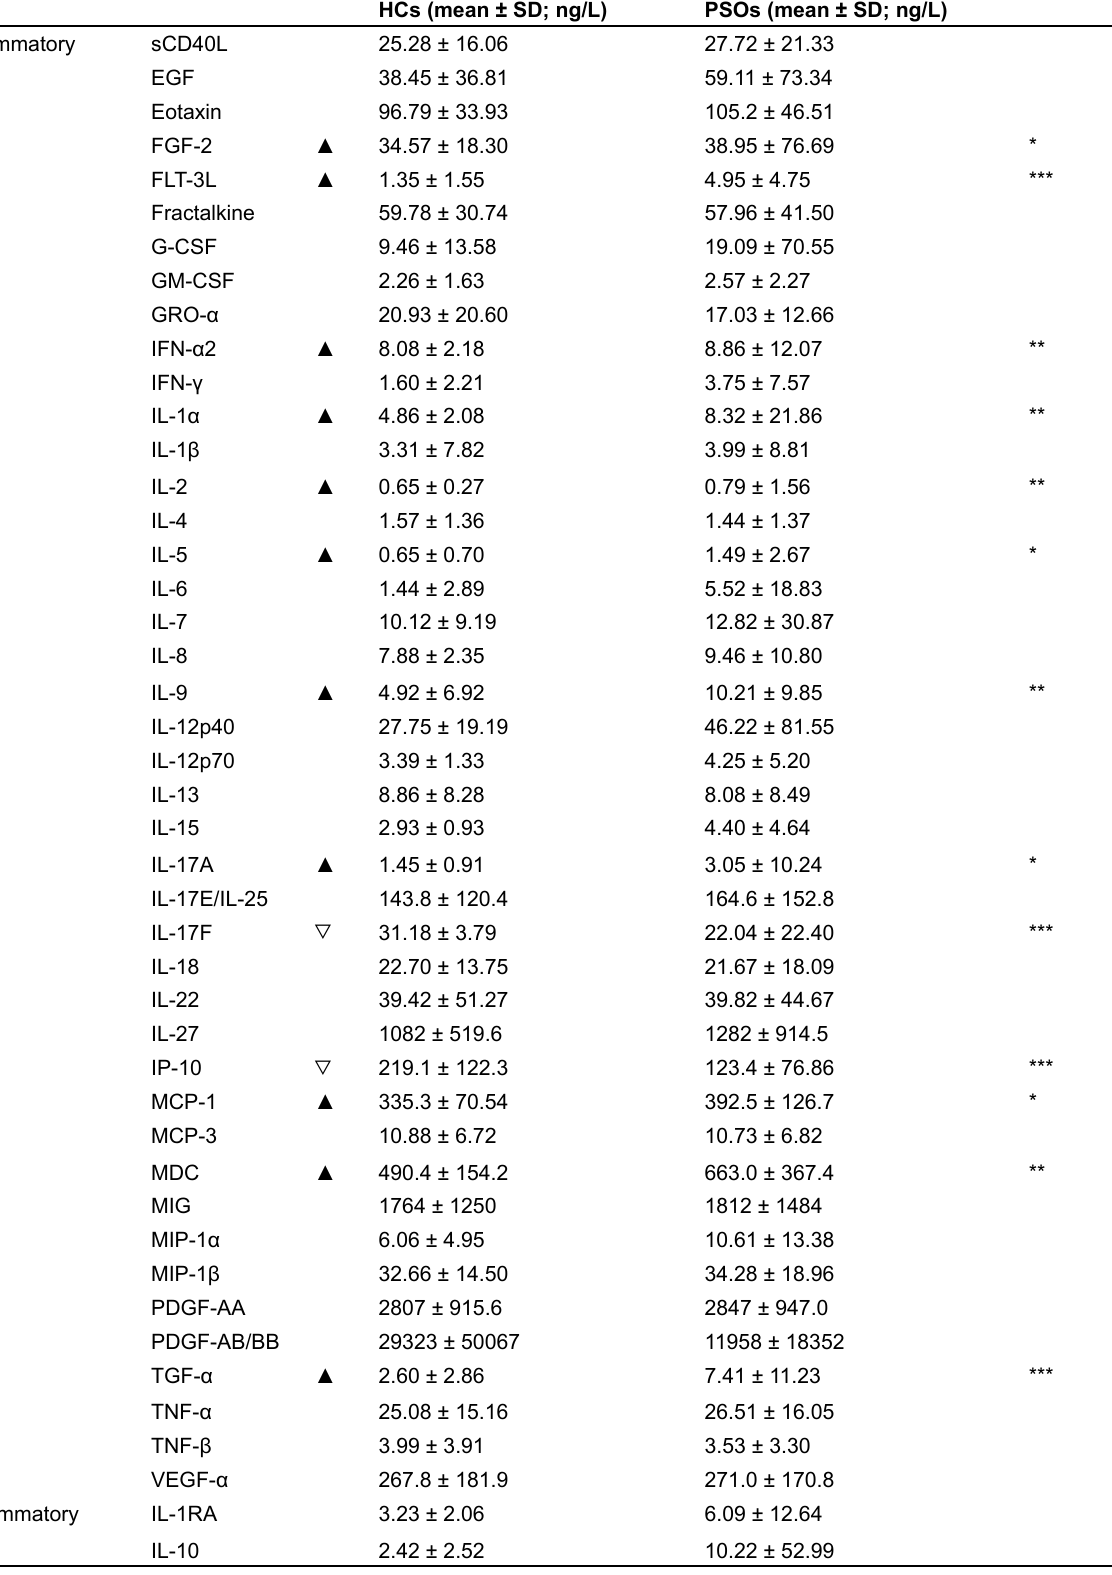
Table 4. Differences in the serum concentrations of cytokines and chemokines between HCs and